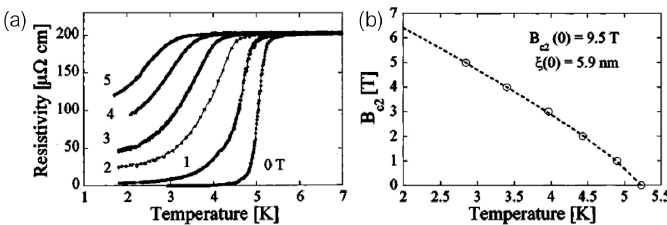
Figure 2. First reported experimental evidence of superconductivity in W-C nanowires prepared by Ga + FIBID. ( a ) Superconducting transition at T c = 5.2 K. ( b ) Dependence of the upper critical field with temperature. Reprinted from [60], with permissions from AIP